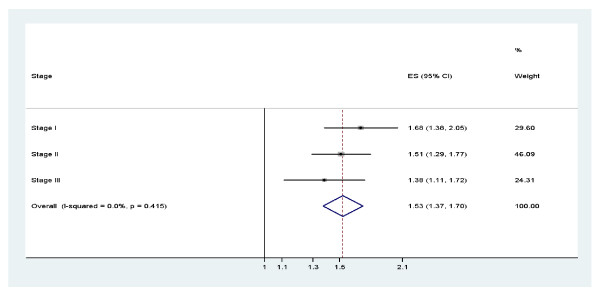
Forest plot. Result of pooled analysis of rs13393577 on the basis of estimated per-allele odds ratio from each stage. CI, confidence interval; ES, effect size.